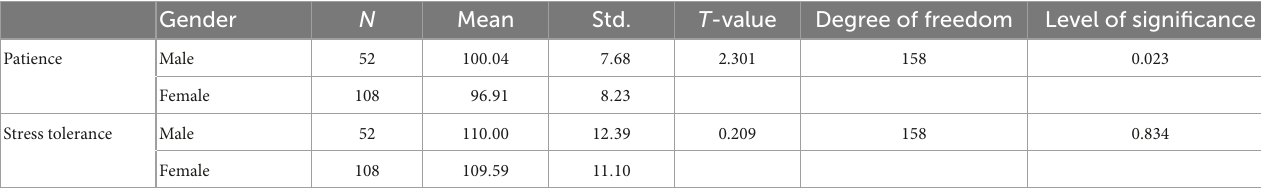
TABLE 3 Results of t -test for variance in total means of the level of patience and stress tolerance, due to social status. Social status N Mean Std. T -value Degree of freedom